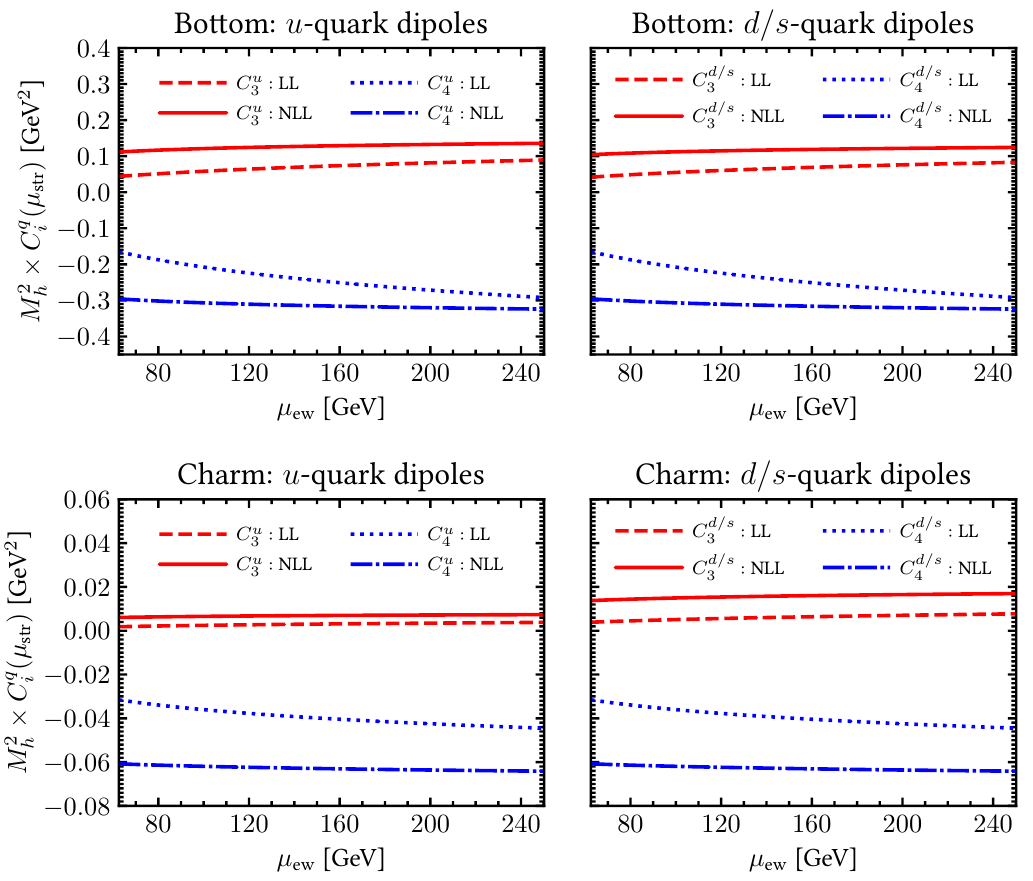
Figure 6 . Residual dependence of the dipole Wilson coefficients on the electroweak matching scale. The upper two panels show the effect of a modified bottom Yukawa, the lower two panels the effect of a modified charm Yukawa. The left plots correspond to operators with external up quarks, while the right plot show operators with down-/strange-quark external legs. In all cases the Wilson coefficients are evaluated in the three-flavor theory at the hadronic scale µ str = 2 GeV, for φ = π/ 2 and κ = 1 b ( c ) b ( c )